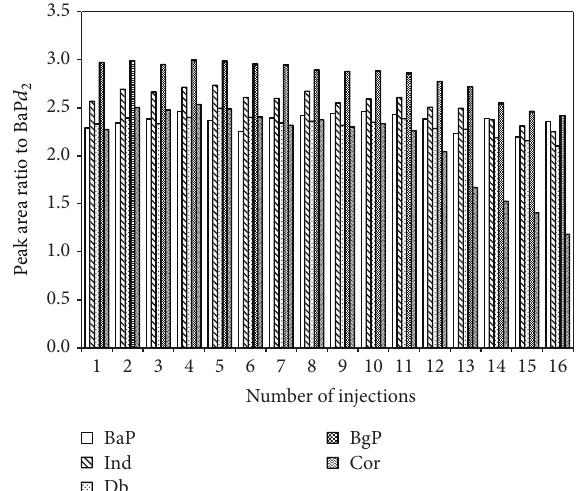
Figure 2: Variation of peak area ratios of targeted PAHs (100ng injection) relative to the peak area of internal standard (BaP d 2 ) as a function of injection